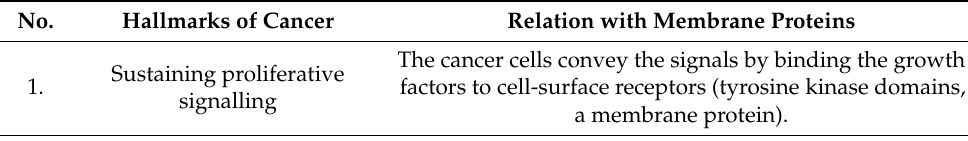
Table 1. Hallmarks of cancer and relation with membrane